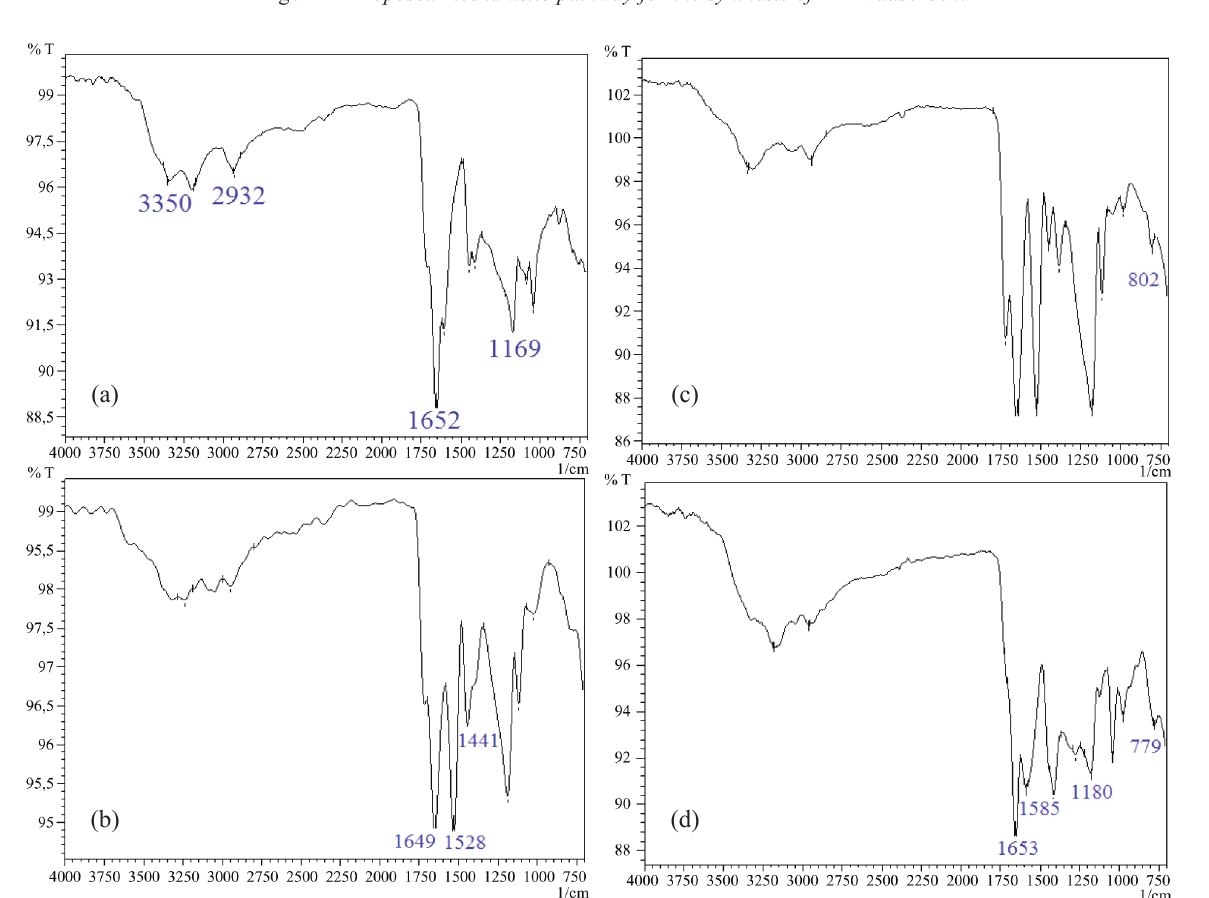
O hydrogel (c), and MHN 3 4